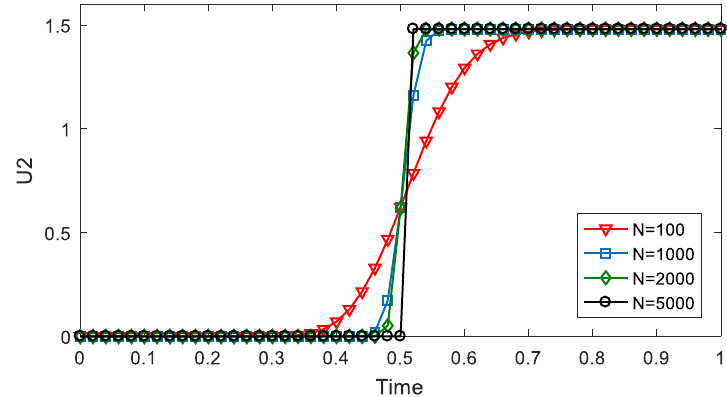
Figure 1. Time change of the concentration of reactant B at 𝑋 = 0.5 simulated by UDS.